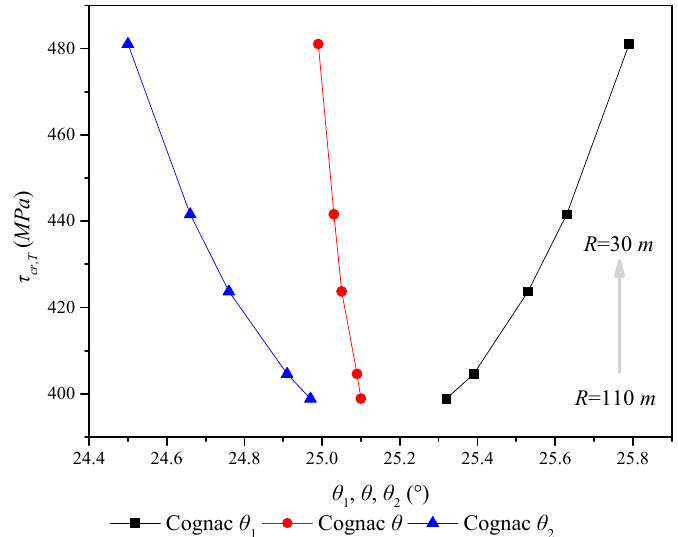
Figure 16. Global shear buckling strength τ cr,T of PCCSW versus different angles θ 1 , θ and θ 2 with varying R. Table 7. Global elastic shear buckling strength of PCCSW with varying curvature radius.